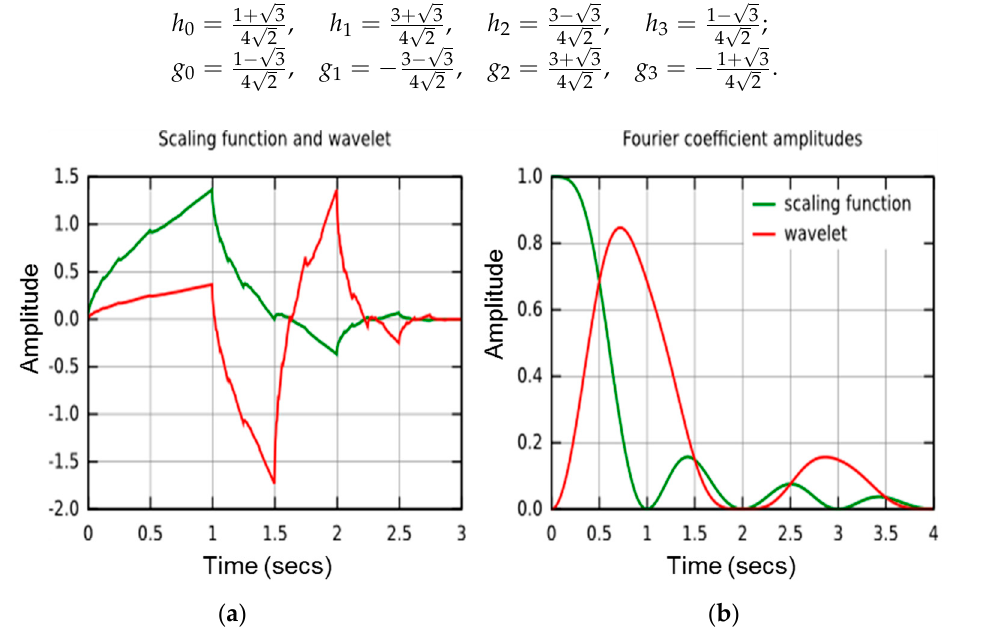
Figure 2. ( a ) Scaling function of Daubechies 4; ( b ) frequency component.